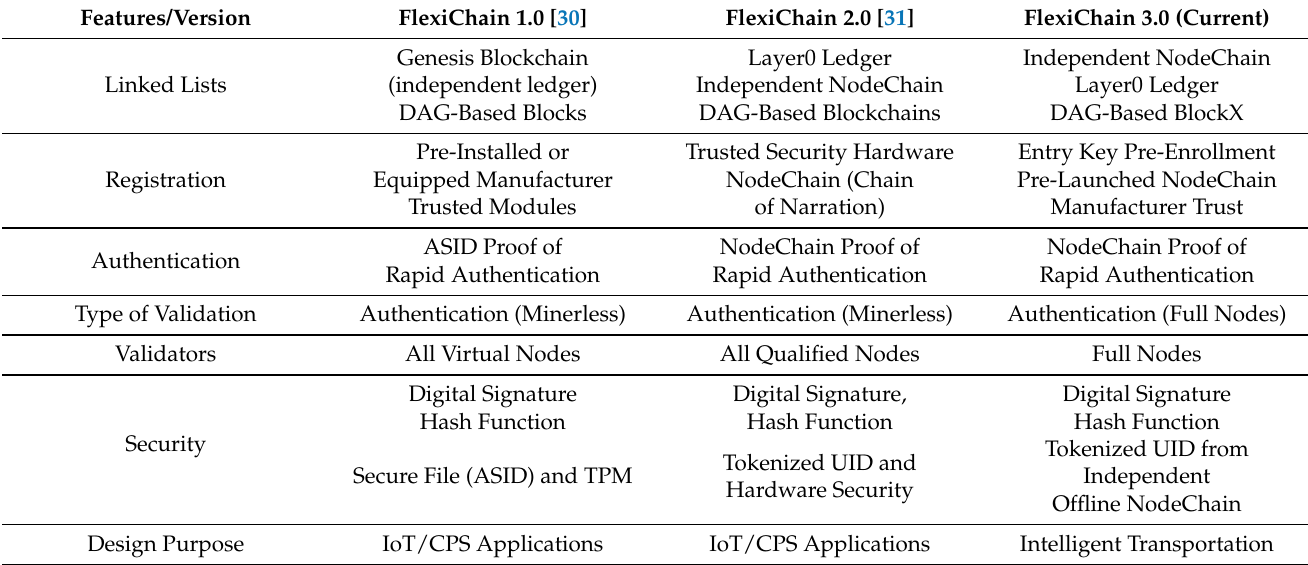
Table 1. Comparative Perspective between FlexiChain